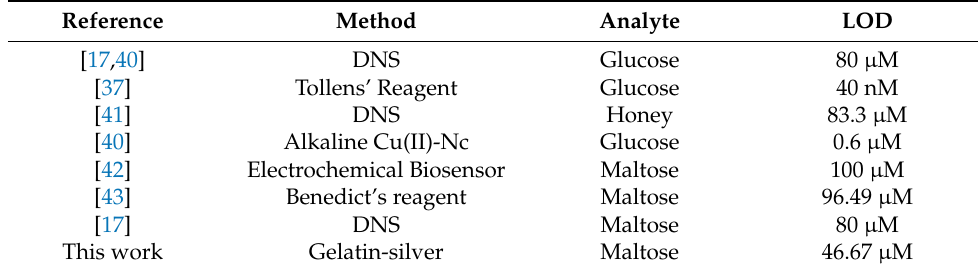
Figure 8. Calibration curve of maltose concentration versus OD. Conditions: See the conditions under Figure 5 using different concentrations of maltose. Table 1. Comparative LOD of reducing sugar with other reported work.